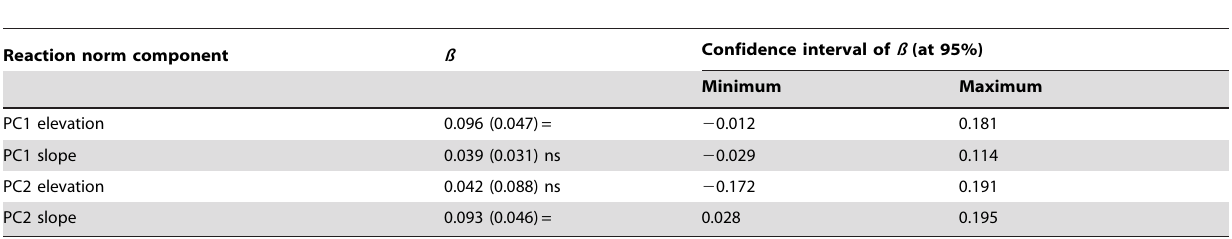
Table 5. Selection gradients (SE) on the components of the reaction norm (slope and elevation) of morphological traits of Brevicoryne brassicae in response to two host